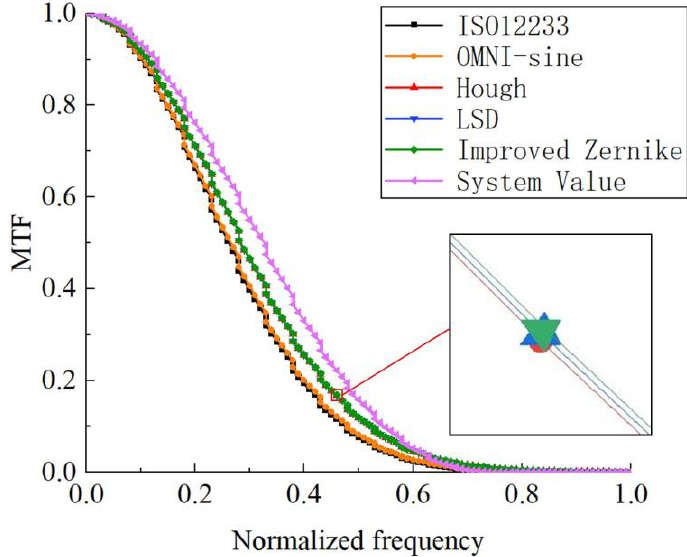
Figure 10. MTF of each method compared with the system value.